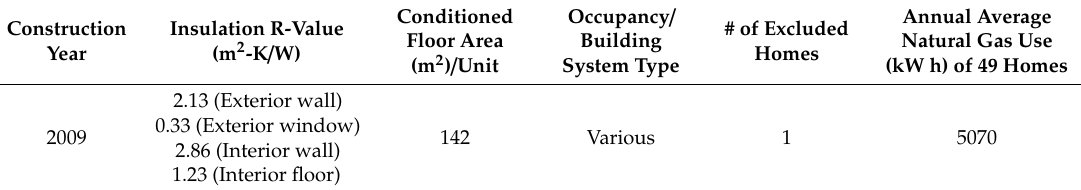
Table 1. Characteristics of the 50 case study residences.